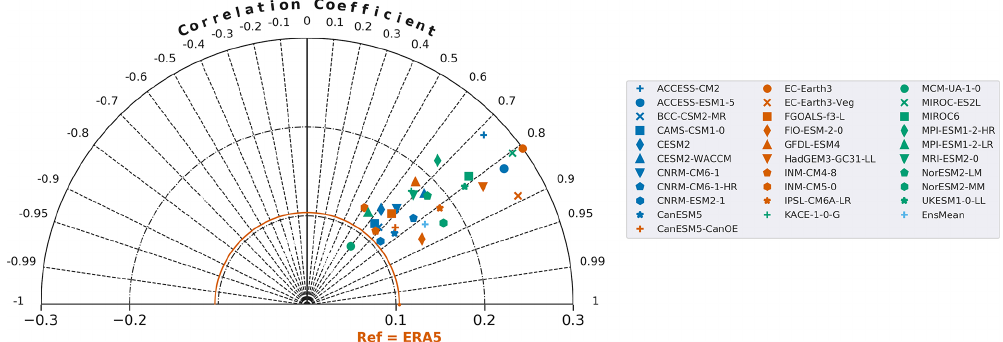
Figure 3. Taylor diagram of the JAS SST pattern in Fig. 2 over the tropical Atlantic box 1, where ERA5 is used as the